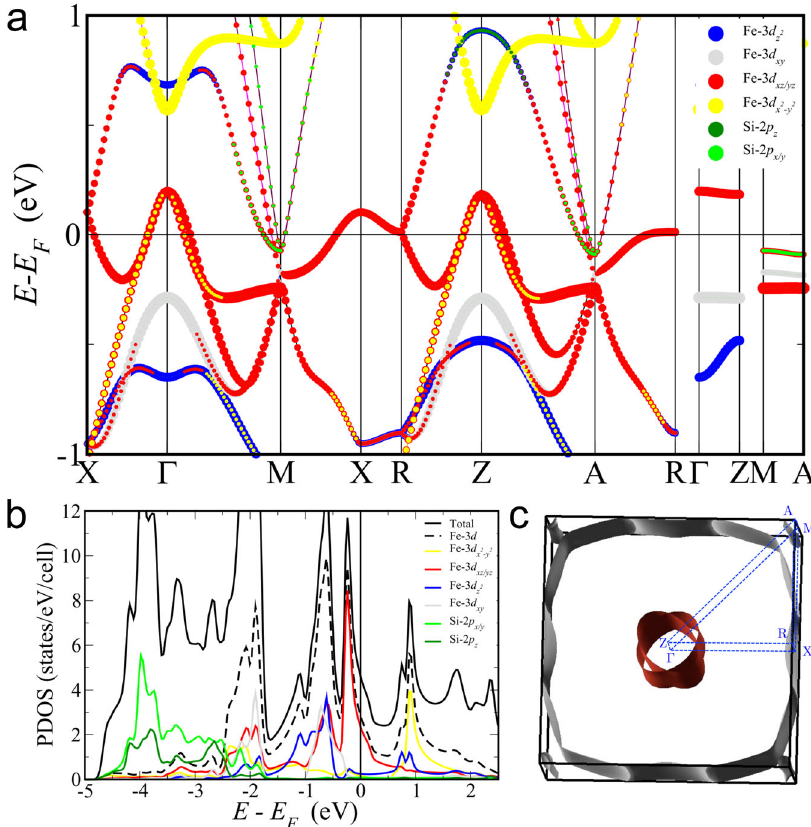
Fig. 5 Calculated electronic band structure. a Orbital-resolved band structure along the high-symmetry directions of the P4/ nmm Brillouin zone. b Orbital-resolved density of states. c Perspective view of Fermi surface computed on the basis of the experimental structure in Table 1. The labels indicate the high-symmetry points and lines correspond to the k -path in ( a